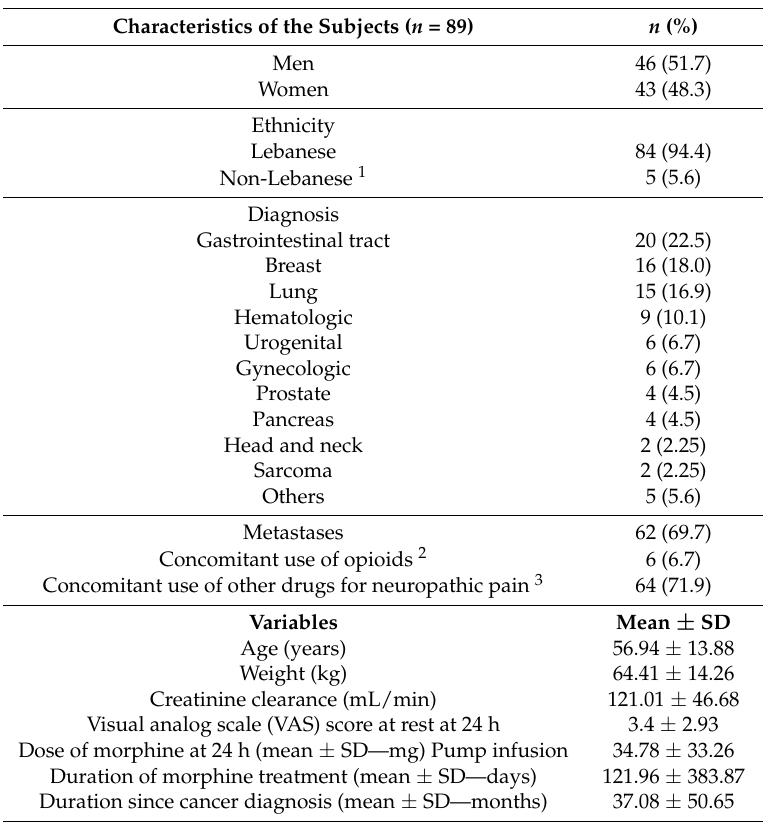
Table 1. Characteristics of the